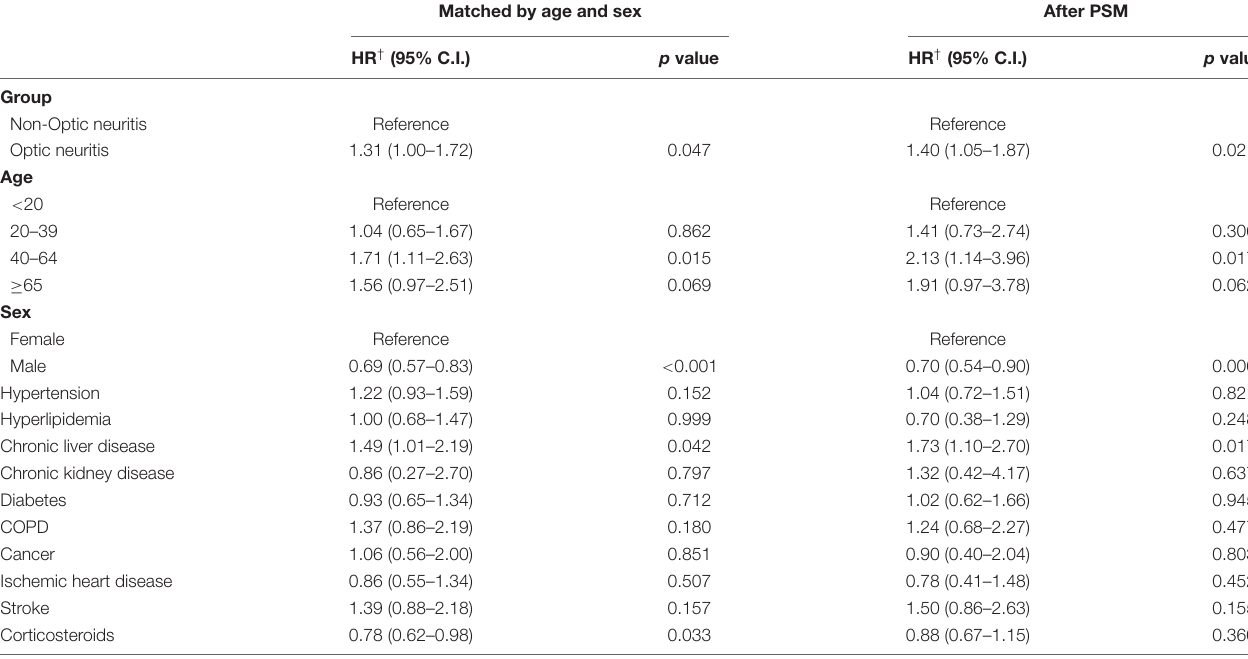
Matched by age and sex